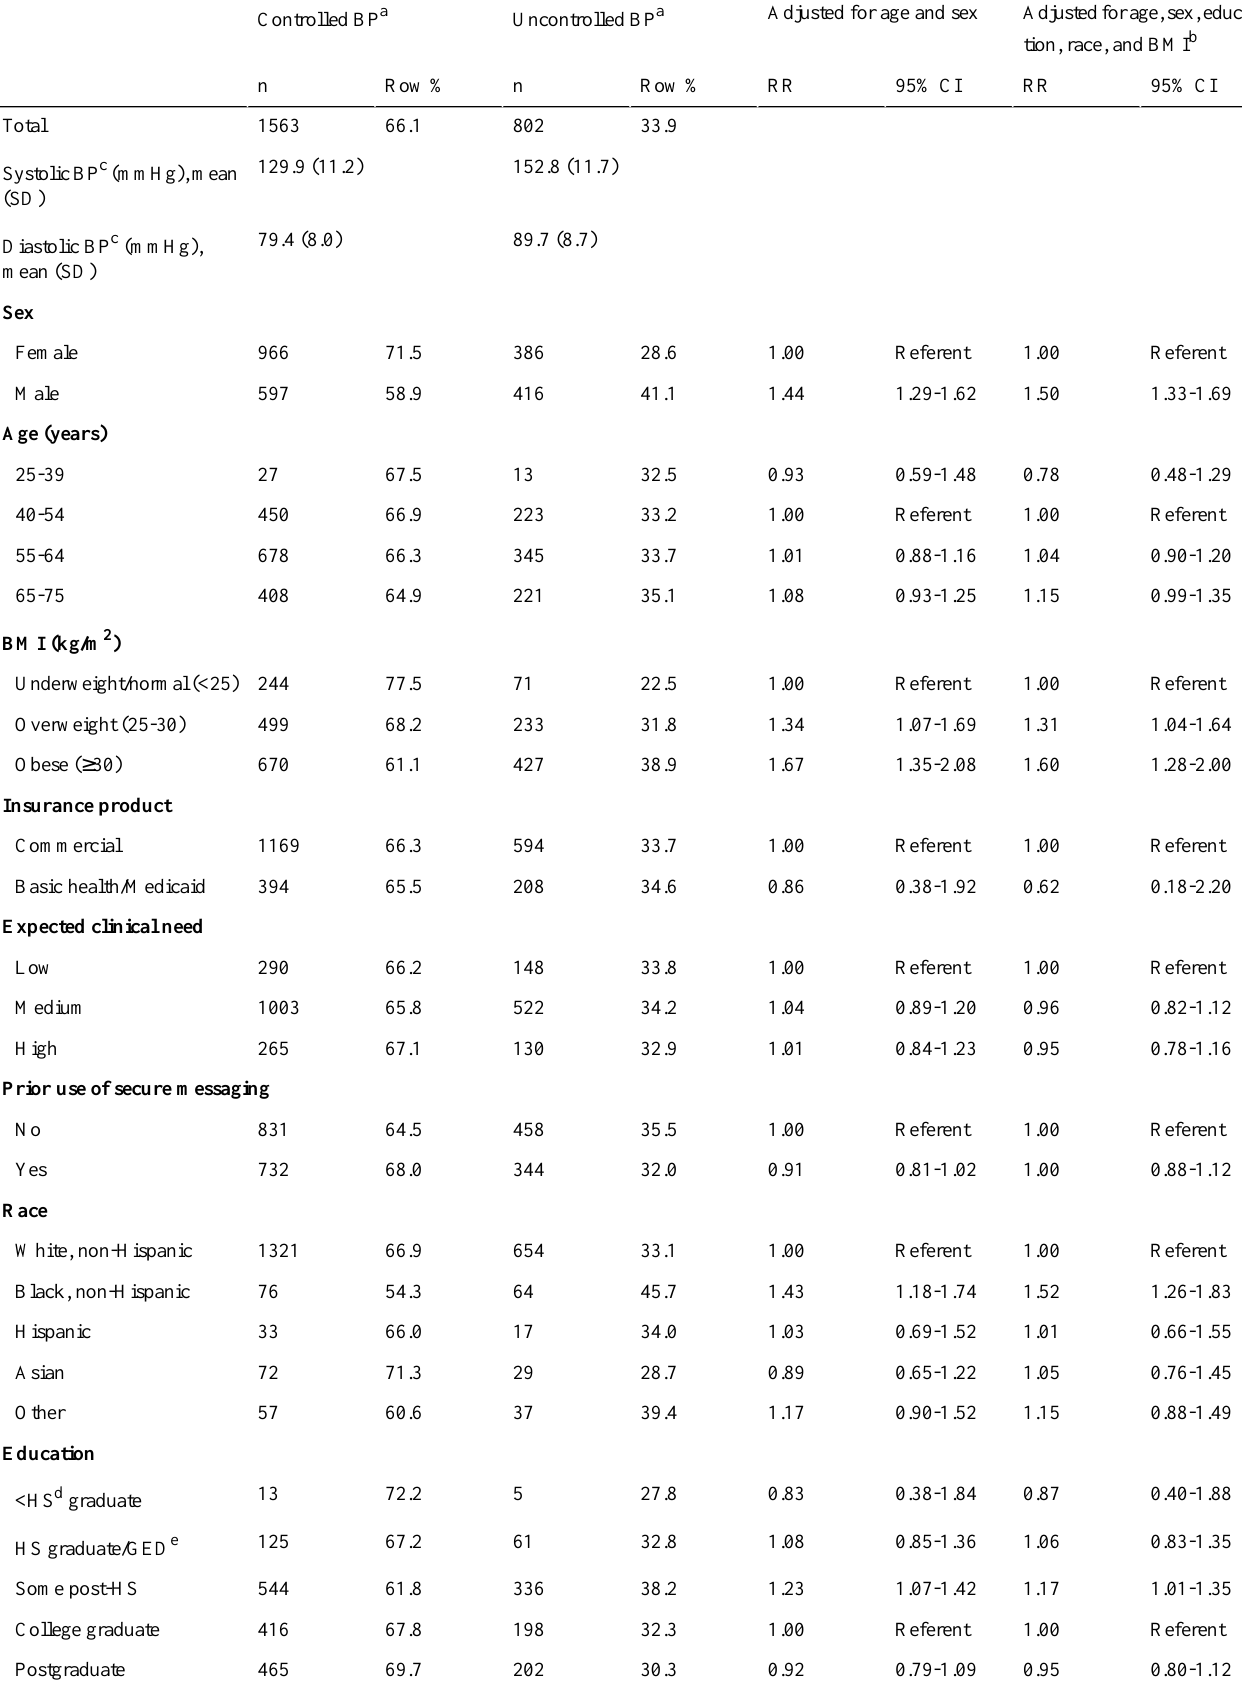
Table 4. Adjusted relative risk (RR) of uncontrolled blood pressure (BP) based on study recruitment guidelines requiring two measures to define uncontrolled BP (n = 2365)